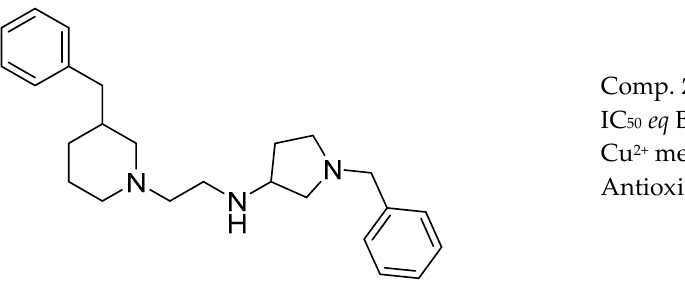
Figure 15. Inhibitor of BuChE with antioxidant and metal-chelating properties from [172].